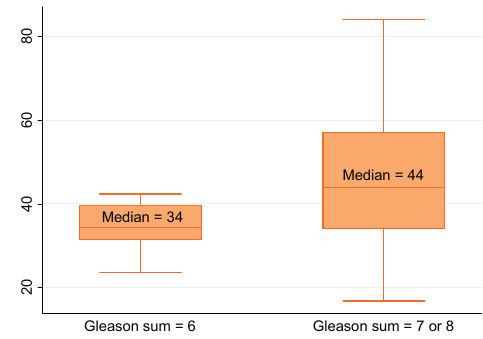
Figure 2. Median PHI according to Gleason sum ( p = 0.013). Biological and pathological findings in 154 men who underwent radical prostatectomies for prostate cancer. (See the note in the legend of the Figure 1 for complete explanation of how to read the figure).